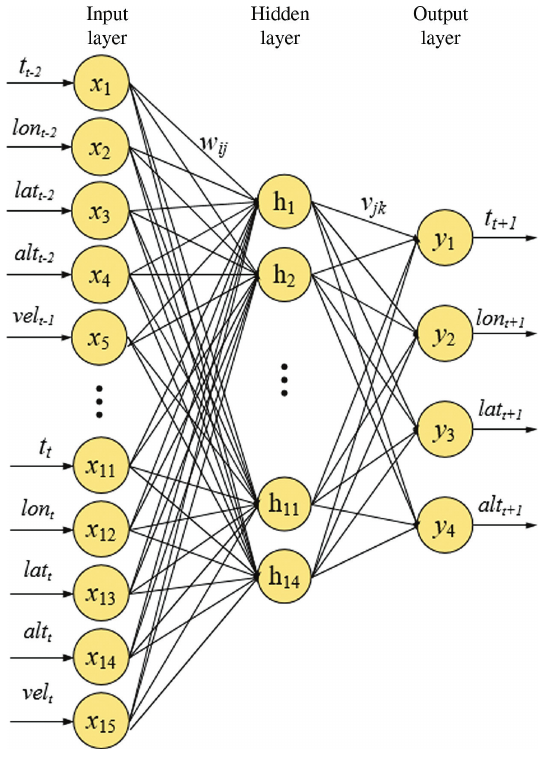
Figure 2: BP Neural Network 4D Trajectory Prediction